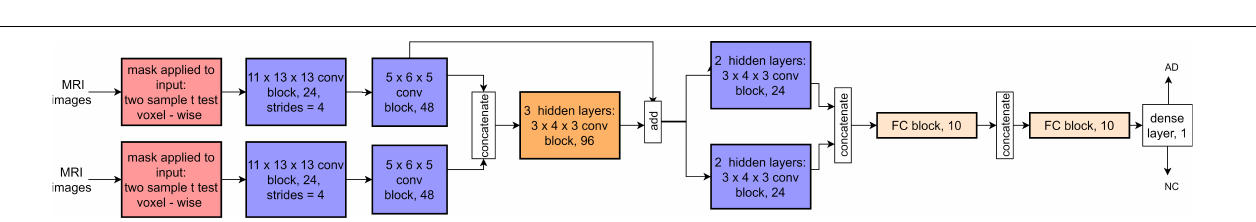
FIGURE 2 | The architecture of our 3D CNN with a Siamese approach. The notation of blocks is as follows: kernel size, (separable) convolutional block, and output channels. If the strides are different from the default value of 1, the new stride value is shown in addition at the end. Each (separable) convolutional block sequentially contains a 3D (separable) convolutional layer, batch normalization, ELU activation, 3D max-pooling (only the convolutional layer), and dropout. FC blocks contain a fully connected layer, batch normalization, ELU activation, and dropout. For details, see Spasov et al.